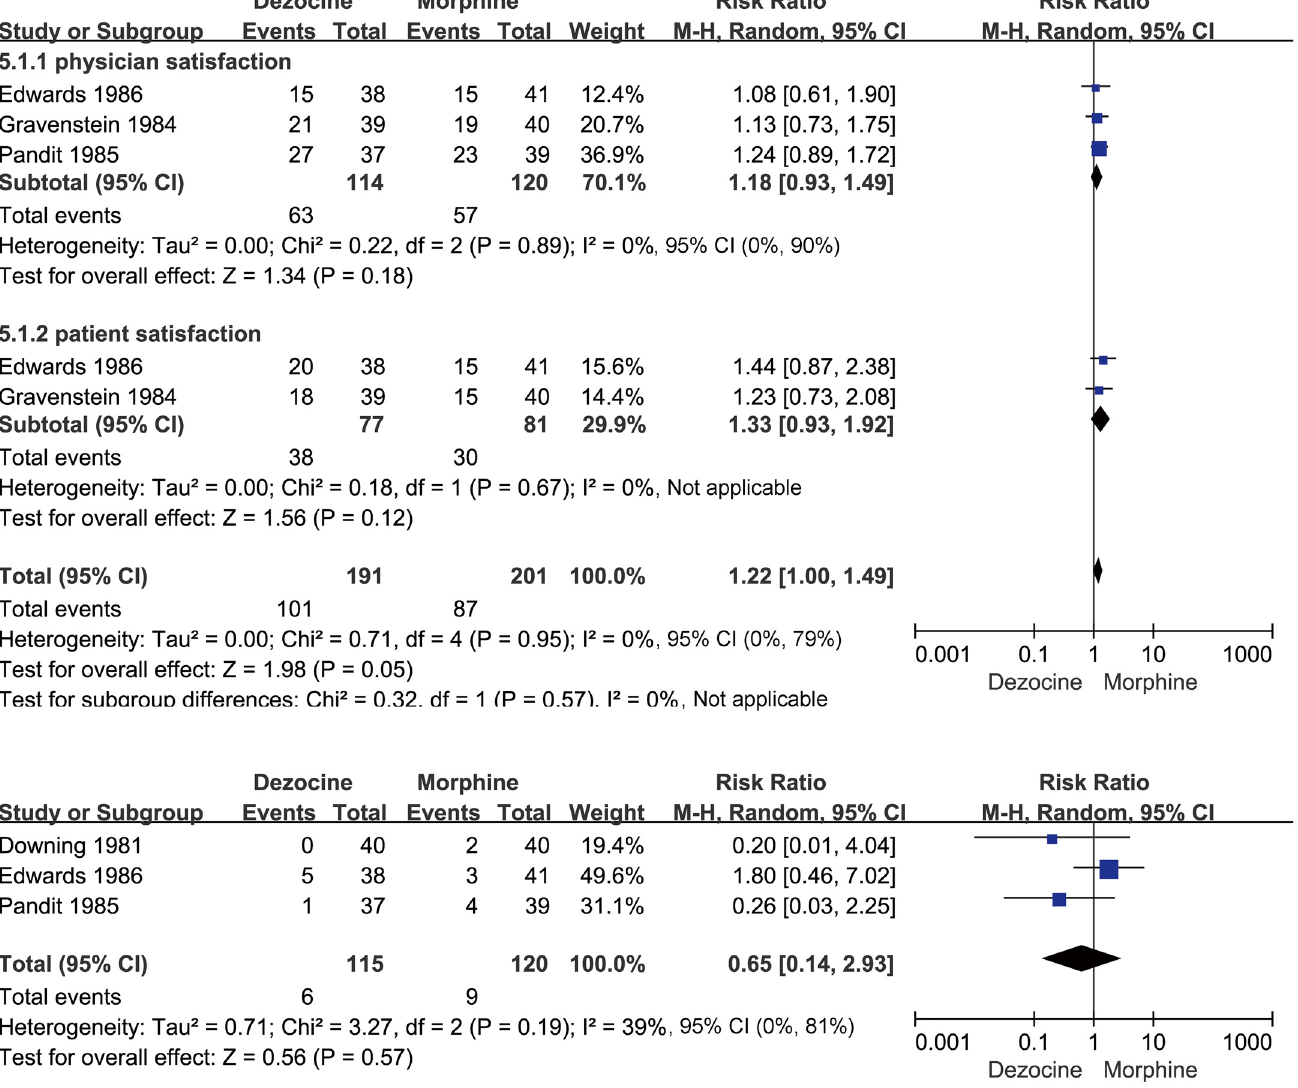
Fig 5. Forest plot of the effects of dezocine versus morphine on physician and patient satisfaction after surgery (A), and postoperative nausea and vomiting (PONV) (B). RR = relative risk; and CI = confidence